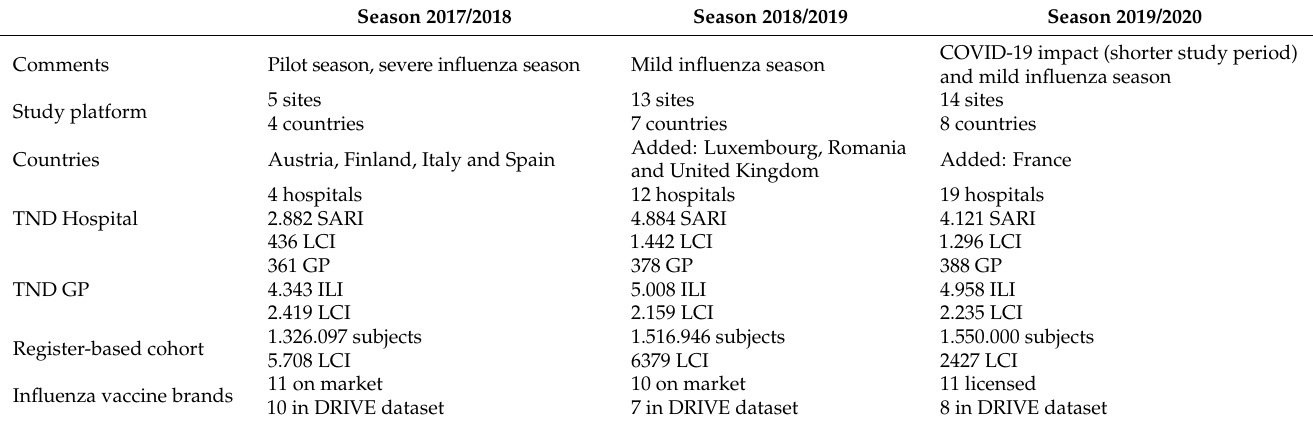
Table 1. Evolution of DRIVE study platform in the years since its start in 2017. Specified information includes the number of participant study sites/European countries; total number of general practitioners (GP)/hospitals participating in the test-negative design (TND) studies; number of influenza-like illness (ILI) cases, severe acute respiratory infection (SARI) cases and laboratory-confirmed influenza (LCI) recruited in the TND; figures for the register-based cohort studies and influenza vaccine brands captured in DRIVE